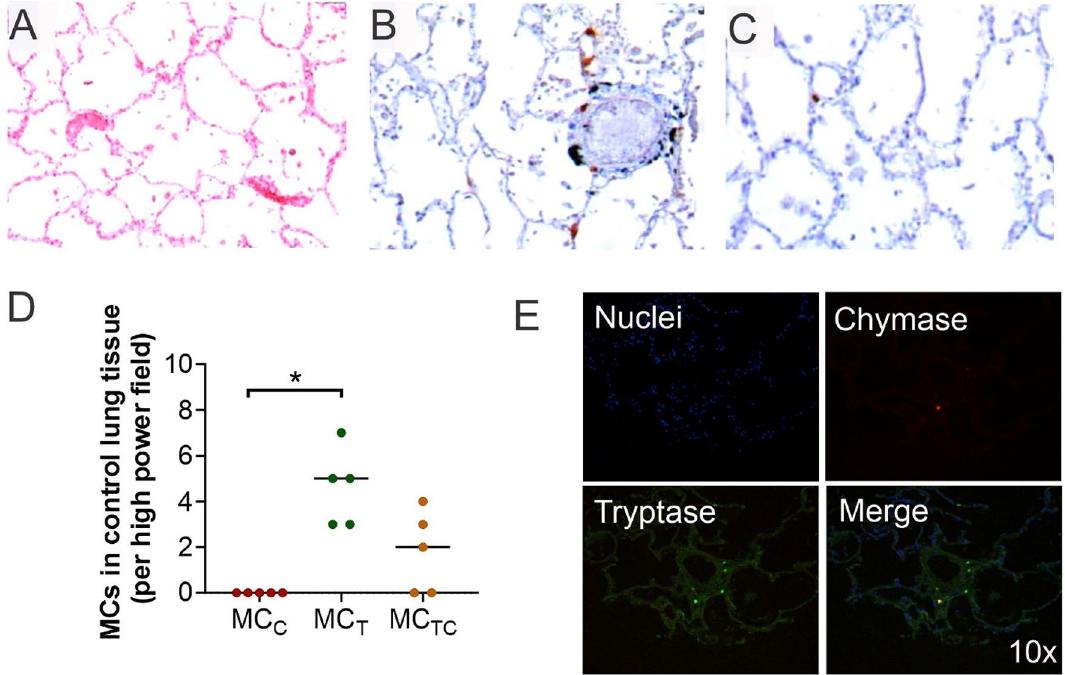
Figure 1. Tryptase positive mast cells are predominant in non-tuberculosis infected human lung tissue. ( A ) Representative micrograph HE staining of lung section from non-TB infected lung autopsy (cause of death heart attack) showing preserved alveolar structure. ( B ) Tryptase Immunostaining shows several positive MCs in the alveolar-capillary interstitium and in the adventitia layer of blood vessels. ( C ) Chymase immunostaining shows occasional positive cells. ( D ) Predominance of tryptase + MCs in non-tuberculous lung tissue was analysed by morphometry in five microarrays. ( E ) Representative immunofluorescence microarray studied with fluorescent microscopy shows MC T (green), MC C (red) and MC TC (merge) surrounding a blood vessel. Shapiro–Wilk test was done to determine normality. Statistical comparison was performed using Kruskal–Wallis test and Dunn´s multiple comparison post-test (adjusted p ≤